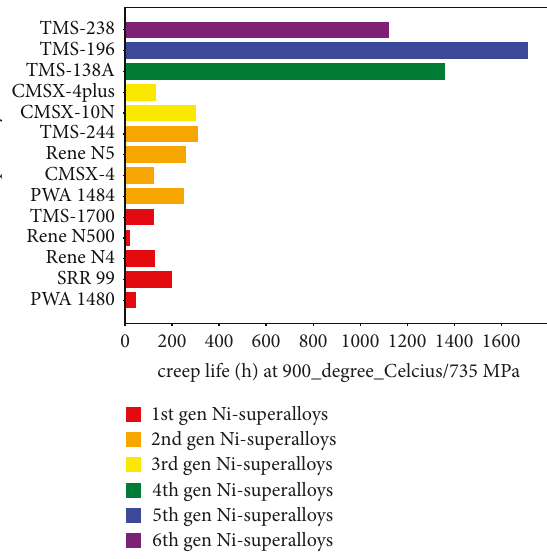
Figure 6: Advancement in creep life with the development of newer generation Ni-superalloys. TMS-196, a 5 th generation Ni- superalloy with the highest creep life, is the most recently developed Ni-superalloy [9, 30–32].